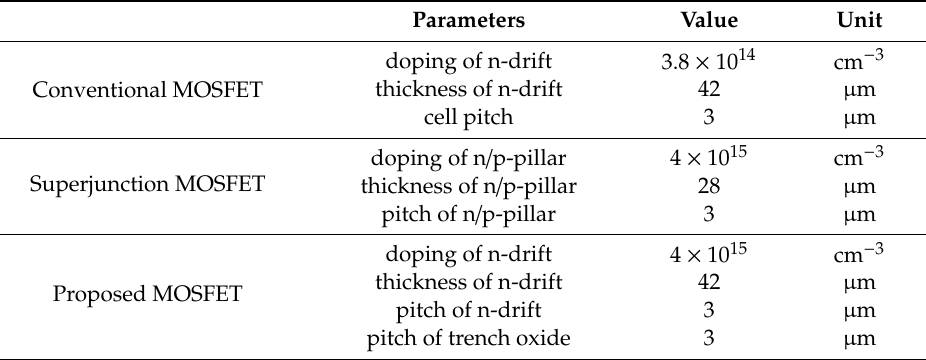
Figure 1. Schematic cross-sectional structures of ( a ) conventional power MOSFET (metal-oxide- semiconductor field-effect transistors), ( b ) SJ-MOSFET, and ( c ) proposed MOSFET featuring deep trench and p-islands. Table 1. Key parameters of the studied MOSFETs.